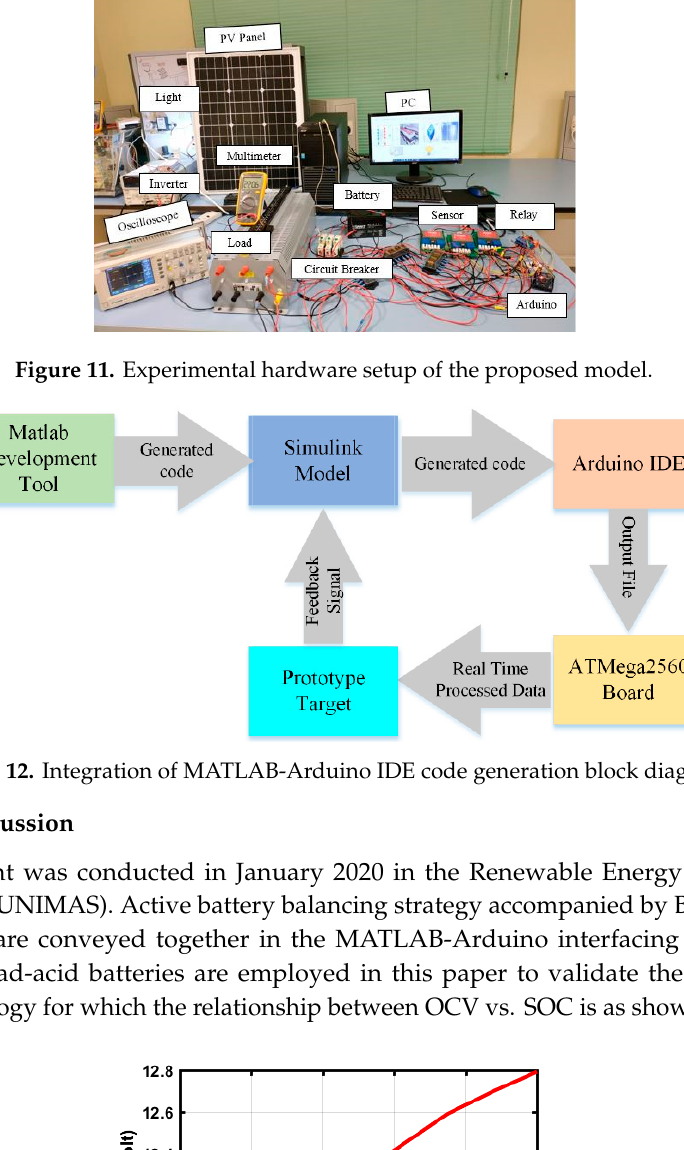
Figure 10. Flowchart for the proposed BMS.